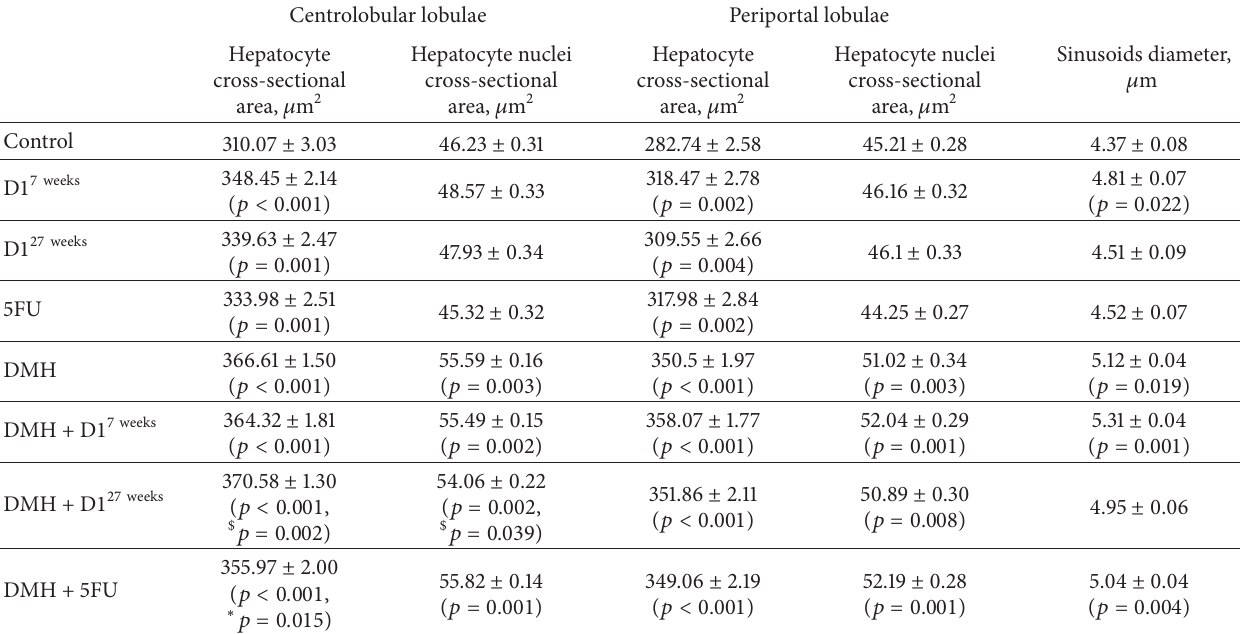
Sinusoids diameter, 𝜇